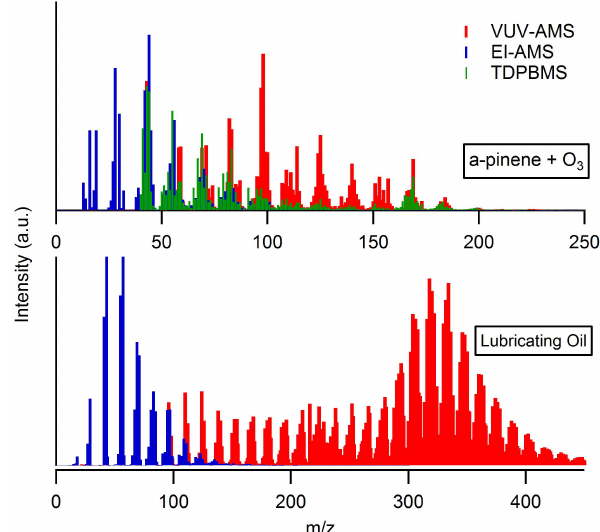
Fig. 1. Mass spectra for primary lubricating oil aerosol (bottom) and SOA from α -pinene+O 3 (top) measured using the VUV-AMS (red), a conventional Aerodyne EI-AMS (blue) and the Ziemann Group EI-AMS (green, α P only). Note the much greater number of high m/z peaks for the VUV mass spectrum compared to the EI mass spectrum. Part of this difference is attributable to the different ionization methods and part to the lower vaporization temperatures employed in the VUV-AMS. EI mass spectra are from (Ulbrich et al., 2009, 2010; Ziemann et al.,